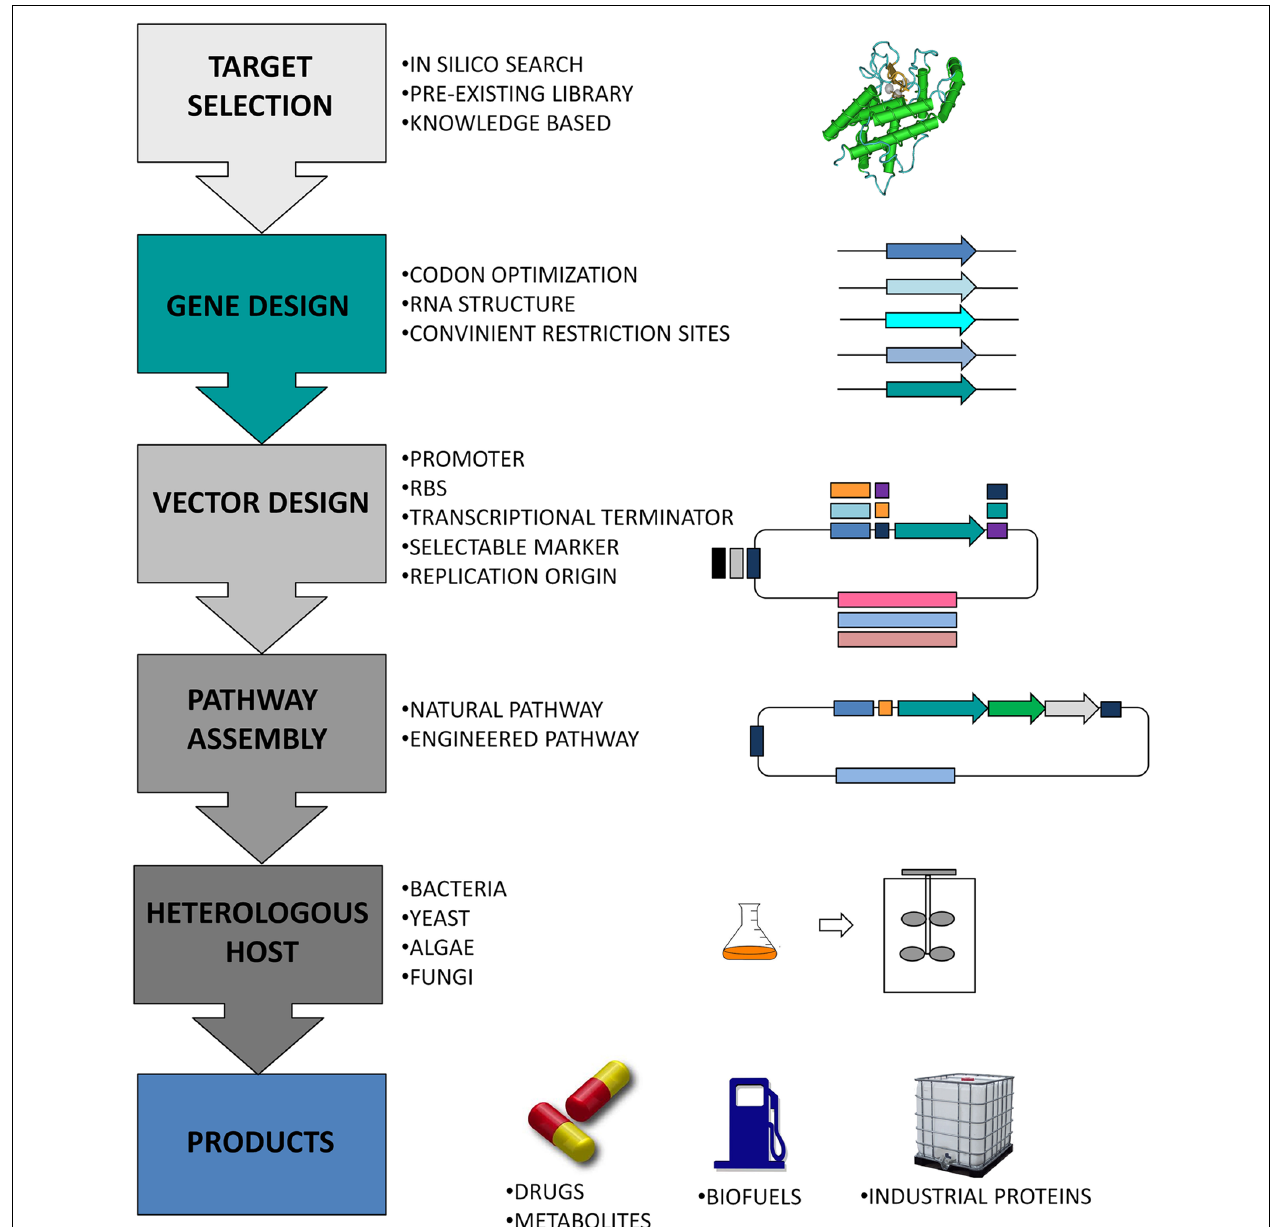
FIGURE 1 | Schematic representation of a synthetic biology network applied to the design of novel bio-based parts and devices, as well as to the engineering of existing natural biological systems for the development of target products .